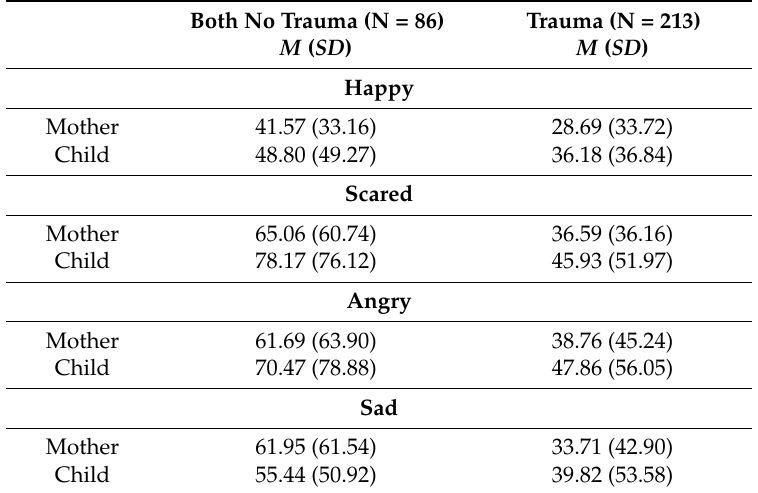
Table 5. Number of words of mothers and children used for describing an emotional